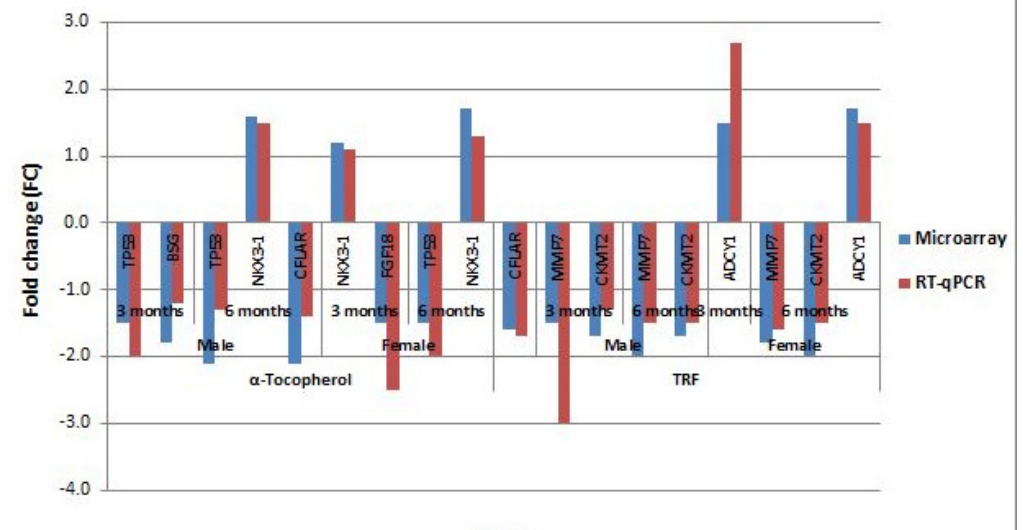
Figure 3 - Comparison of gene expression between the microarray and RT-qPCR